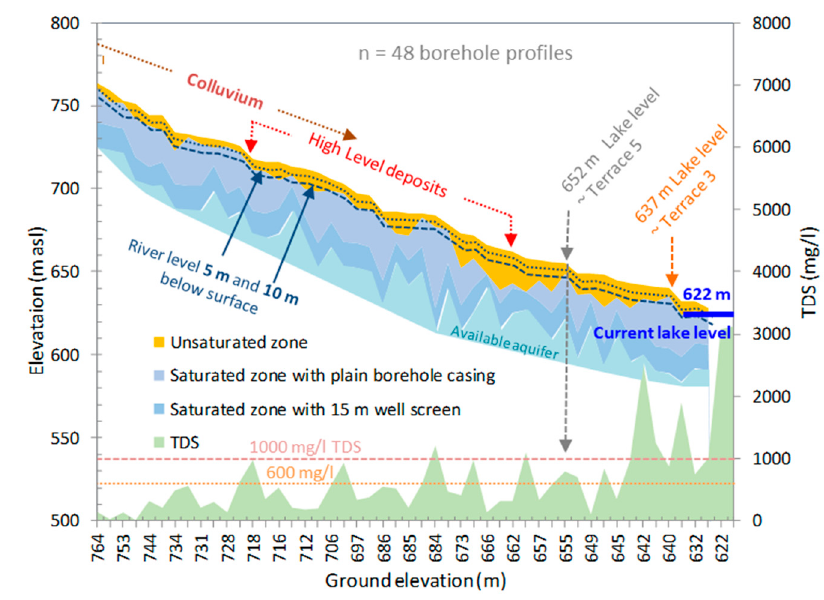
Figure 6. Plot of ground elevation versus borehole (n = 48) depths, estimated variation of unsaturated zone, saturated zones plain cased and screened and potentially available aquifer estimated from the deeper boreholes; and, a lower profile of borehole and Lake Chilwa sampled TDS water quality.